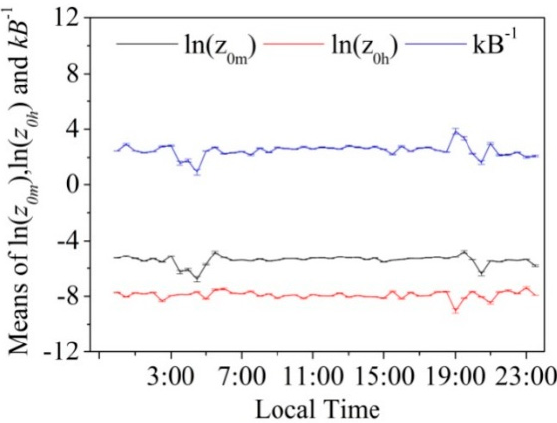
Figure 8. Diurnal variations in the mean values of ln( z 0 m ), ln( z 0 h ), and kB − 1 from 5 January to 31 December 2010.